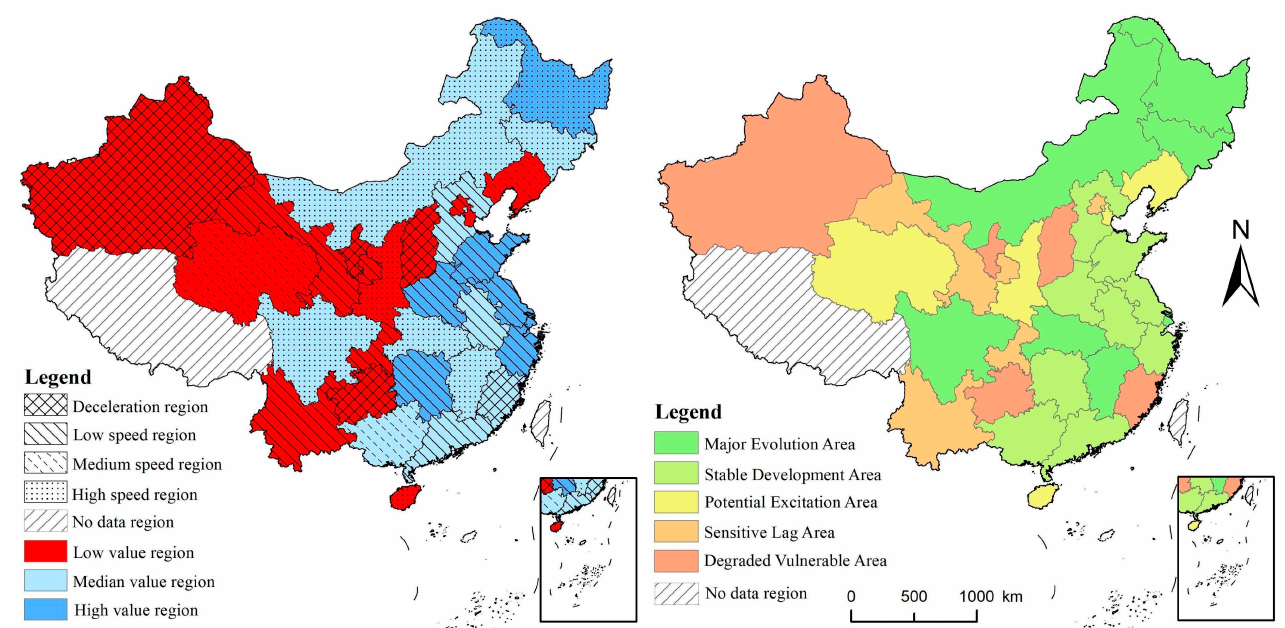
Figure 5. Cultivated land use system resilience (CLSR) partition in some areas of mainland China. Note: The ( left ) figure shows the growth rate of cultivated land use system resilience (CLSR) from 2015 to 2018 and the current situation of CLSR in 2018; classification overlay results in CLSR partition, as shown in the figure on the ( right